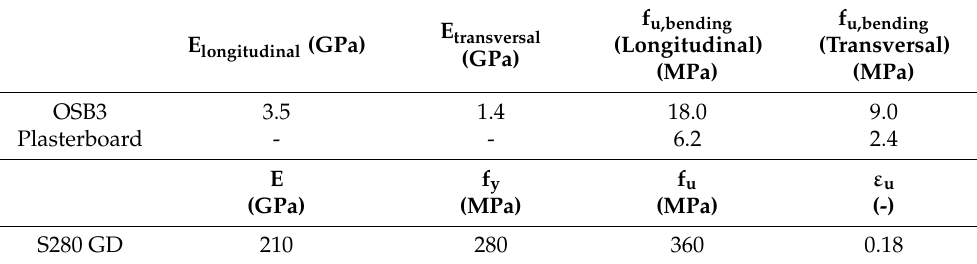
Table 2. Nominal values of the mechanical properties of materials.